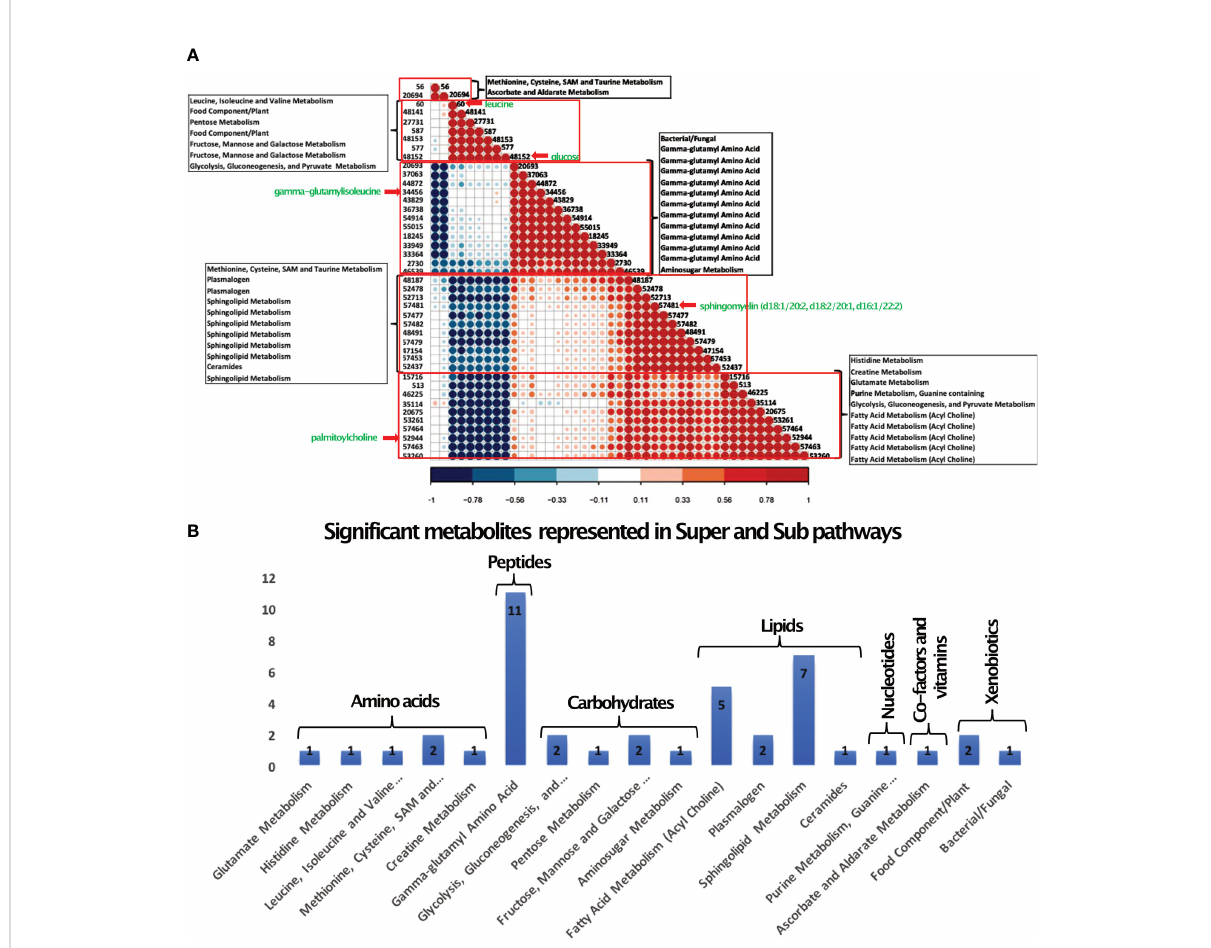
FIGURE 3 Pathway analysis of Serum Metabolites. (A) Pearson correlation-based clustering of the signi fi cant metabolites. Five major clusters obtained are shown in red boxes. Each metabolite is represented by their compound identi fi cation (Table 2 shows the respective metabolites). The sub pathways of the metabolites are represented in the boxes. The fi ve metabolites chosen for data integration are indicated by a red arrow. (B) 43 metabolites were categorized into seven super pathways, including lipids (35%), peptides (26% gamma-glutamyl amino acids), amino acids (10%), carbohydrates (17%), nucleotide (2% purine metabolism), cofactors and vitamins (2% ascorbate and aldarate metabolism), and xenobiotics